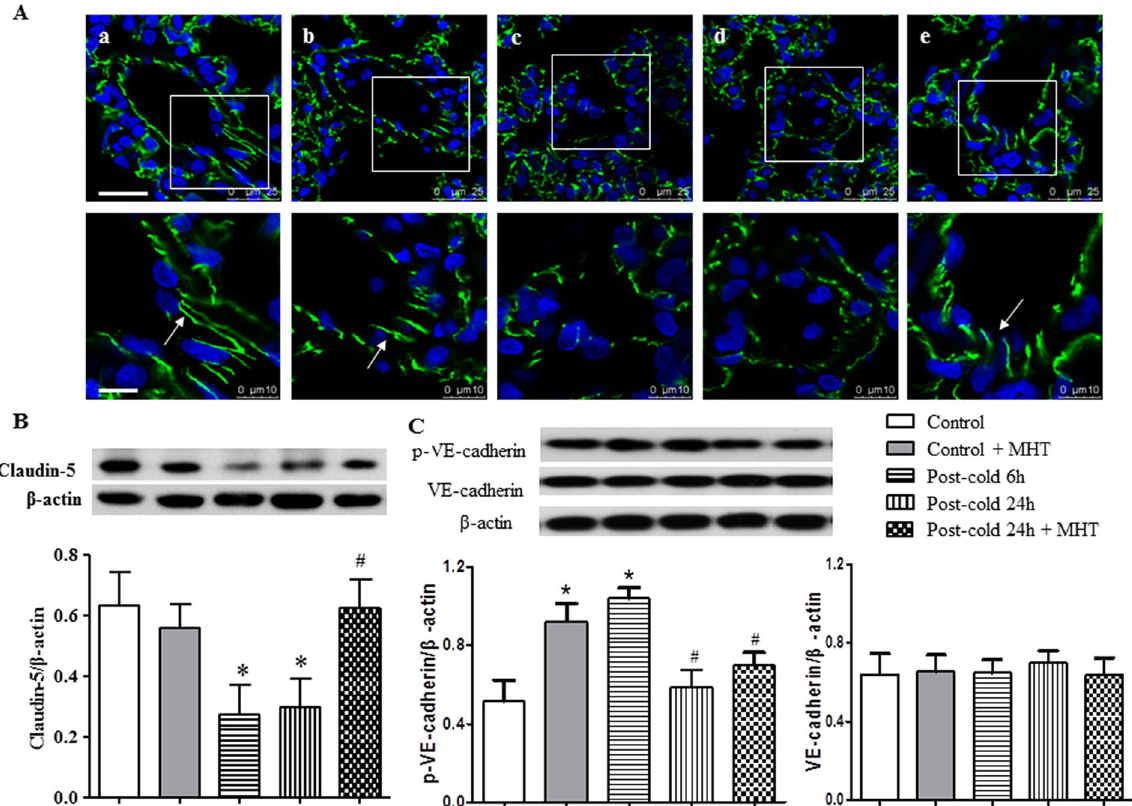
Figure 4. Effect of MHT post-treatment on the expression of Claudin-5 and activation of VE-cadherin in the rat lung tissues. ( A ) Representative immunofluorescence confocal images of rat lung tissue in Control (a), Control + MHT (b), Post-cold 6 h (c), Post-cold 24 h (d), and Post-cold 24 h + MHT (e) group, respectively. Bar = 25 μ m. The area within the rectangle in each image in upper panel is enlarged and presented below. Bar = 10 μ m. The sections were immunochemically stained for Claudin-5 (green). ( B ) Western blot for the expression of Claudin-5 in different groups with the quantification of Claudin-5 showing below. ( C ) Western blot for the VE-cadherin in different groups with the quantification of Claudin-5 showing below. N = 4. Results are presented as mean ± SE. * P < 0.05 vs. Control group; # P < 0.05 vs. Post-cold 24 h